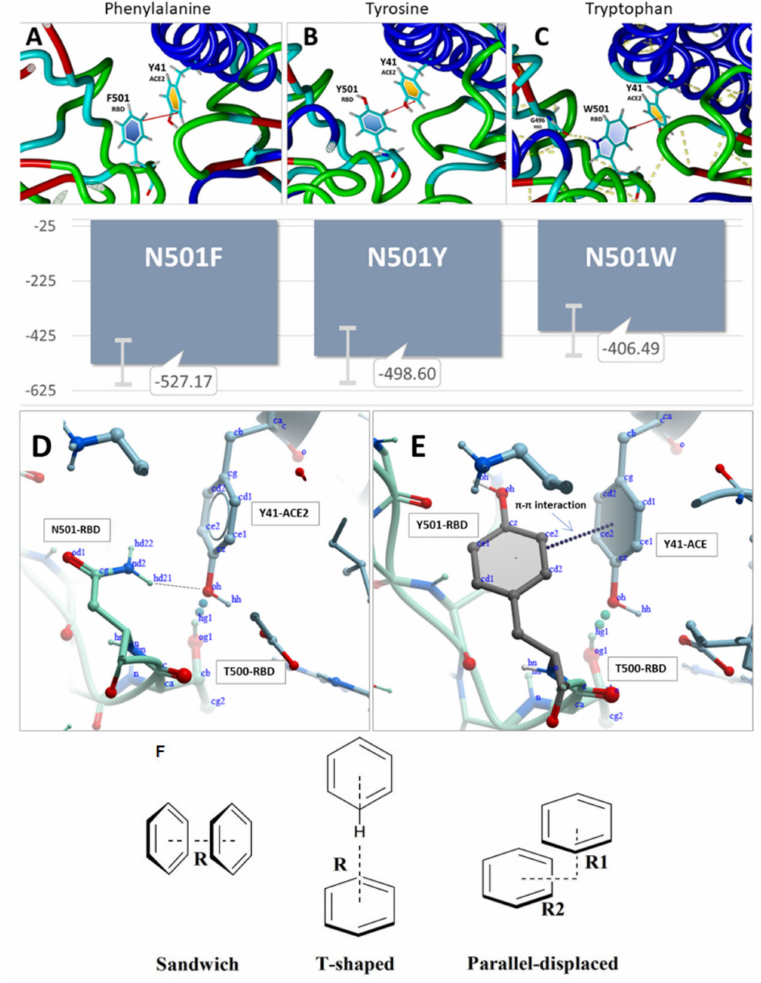
Figure 7. RBD-ACE2 binding energies (KJ/mol) derived from the MD simulations. N = approxi- mately 120 in each case. Higher (less negative) energies correspond to stronger RBD-ACE2 binding. Upper Panel : Intermolecular π - π interactions (red lines) between Y41 of the ACE2 receptor and ( A ) phenylalanine (N501F), ( B ) tyrosine (N501Y), or ( C ) tryptophan (N501W) substitutions at the N501x position of the SARS-CoV-2 S-protein RBD (PDB entry 6LZG). Each RBD-ACE2 conforma- tion shown was obtained following 9.0 ns of MD equilibration at 311 O K in physiological saline. Middle Panel : ( D ) Hydrogen bonding between donor atom hd21 of N501 of the RBD and the phenyl oxygen acceptor (oh atom) of residue Y41 of the ACE2 receptor. ( E ) π - π interactions be- tween Y41 of the ACE2 receptor and tyrosine (N501Y) of S-protein RBD. The distances between RBD Residue/Atom and ACE2 Residue/Atom may be viewed in the Supplementary Materials. Lower Panel : ( F ) Sandwich, T-shaped, and parallel-displaced configurations of the benzene